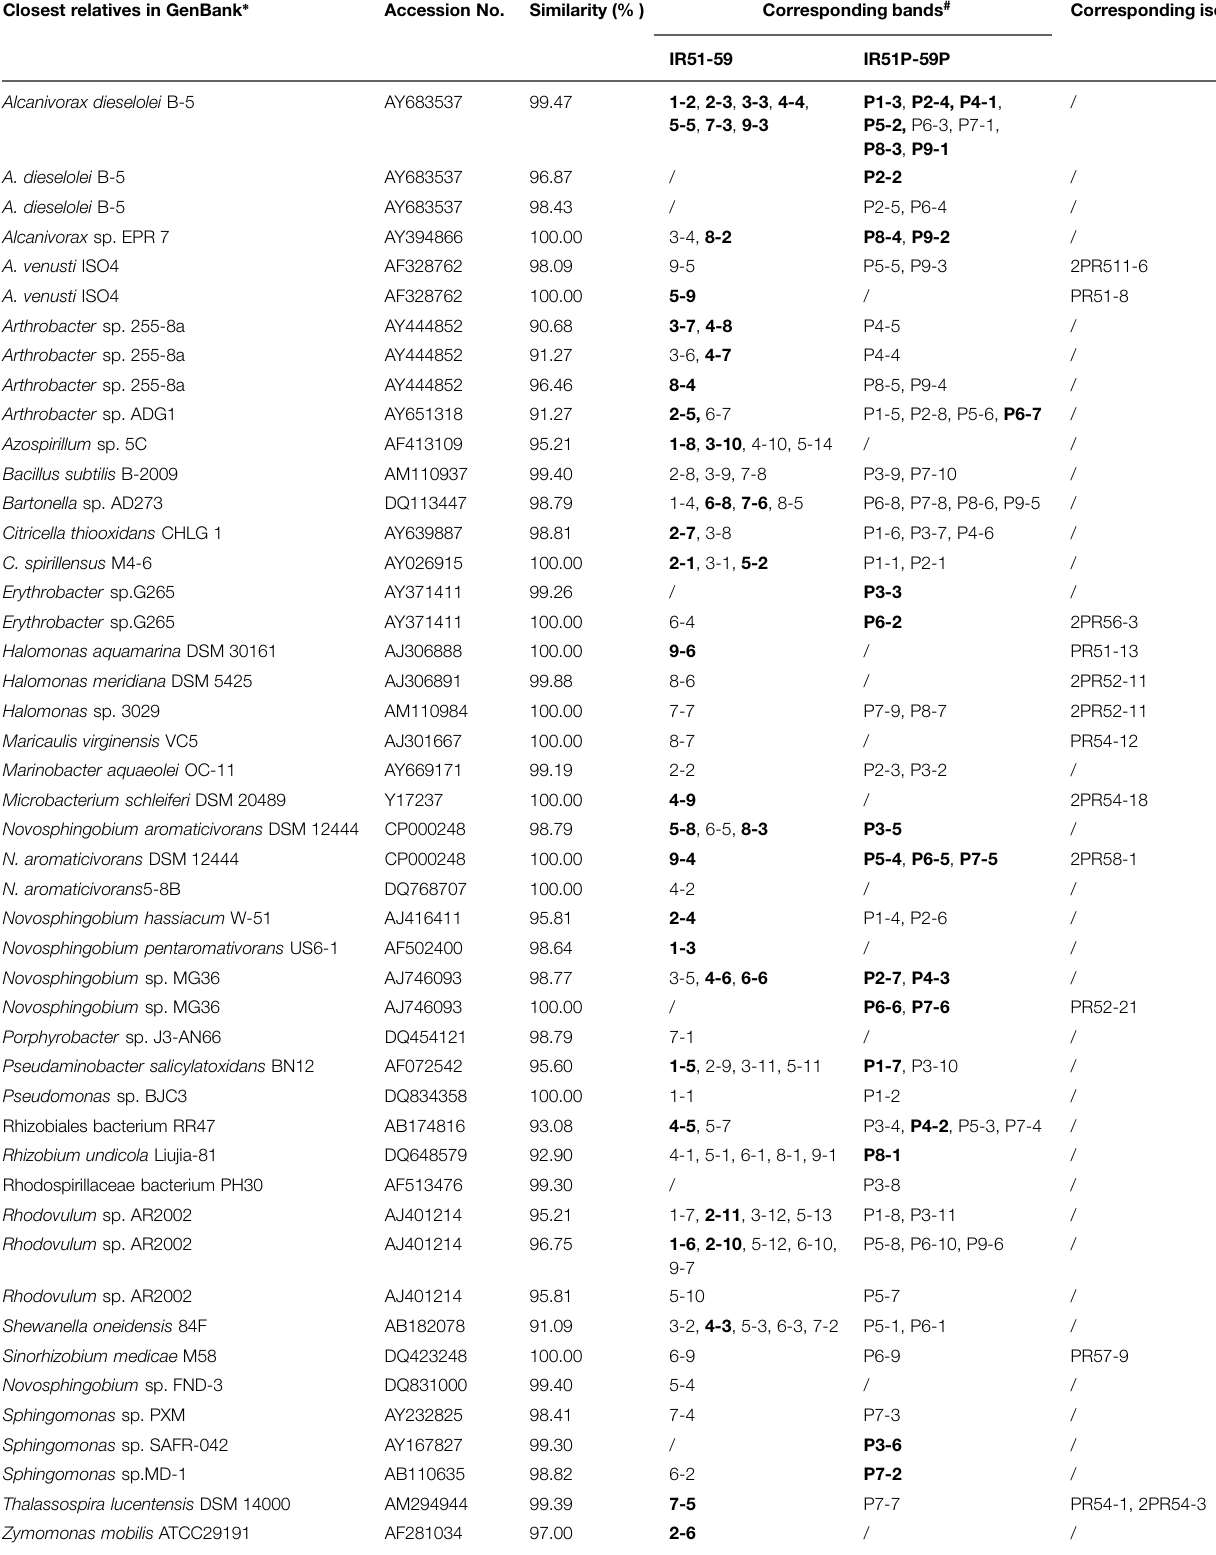
TABLE 1 | The bacteria detected by Denaturing Gradient Gel Electrophoresis (DGGE) in PAHs- and Phe-degrading consortia. Closest relatives in GenBank